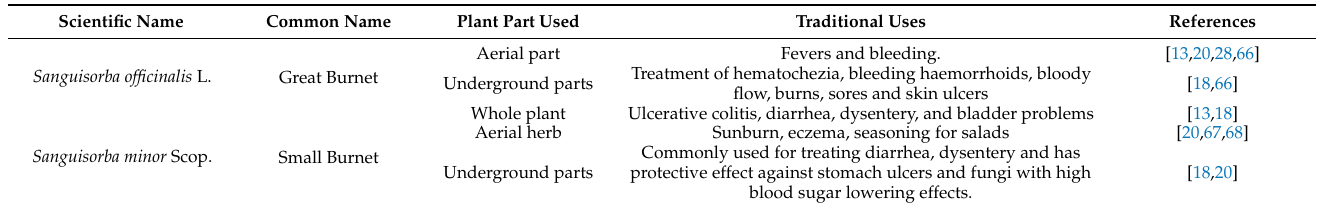
Table 3. Traditional use of different parts of S. officinalis and S. minor